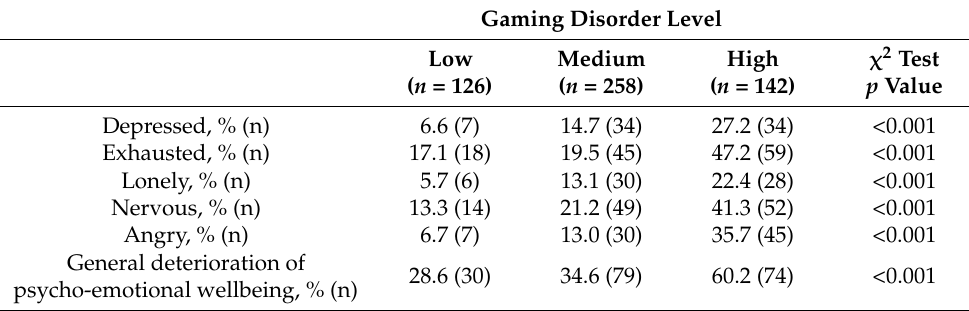
Table 2. Last-month psycho-emotional wellbeing by gaming disorder